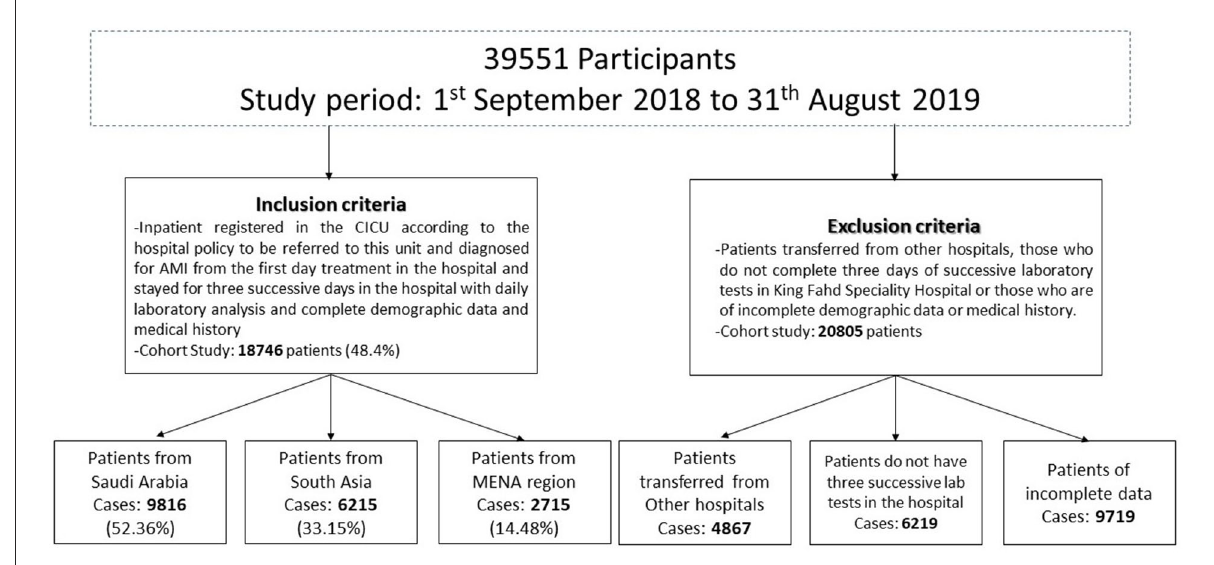
FIGURE1 Flow chart of the cohort study.